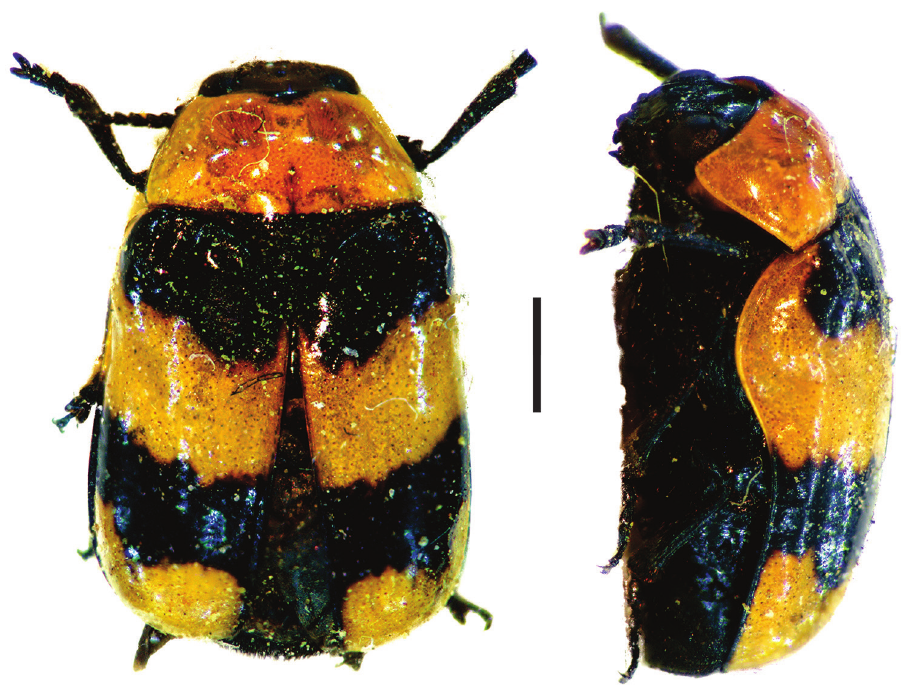
Figure 7. Dachrys succincta (Erichson) (1) , left: habitus (dorsal view), right: habitus (lateral view). Type species. Dinophthalma ophthalmica Lacordaire, 1848 designated by Monrós (1953a: